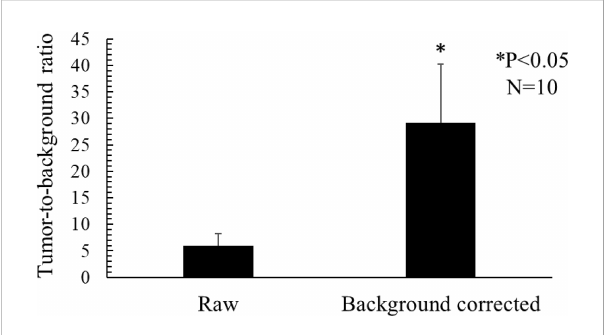
FIGURE 8 Mean tumor-to-background ratios for the raw and background corrected fl uorescence images.